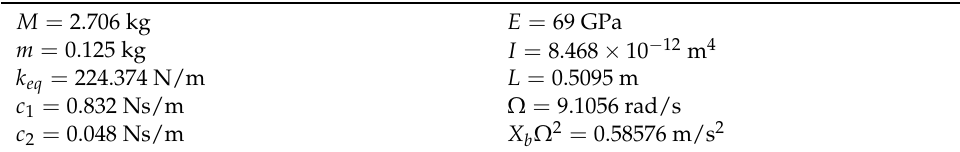
Table 1. Parameters of the nonlinear vibrating system. M = 2.706